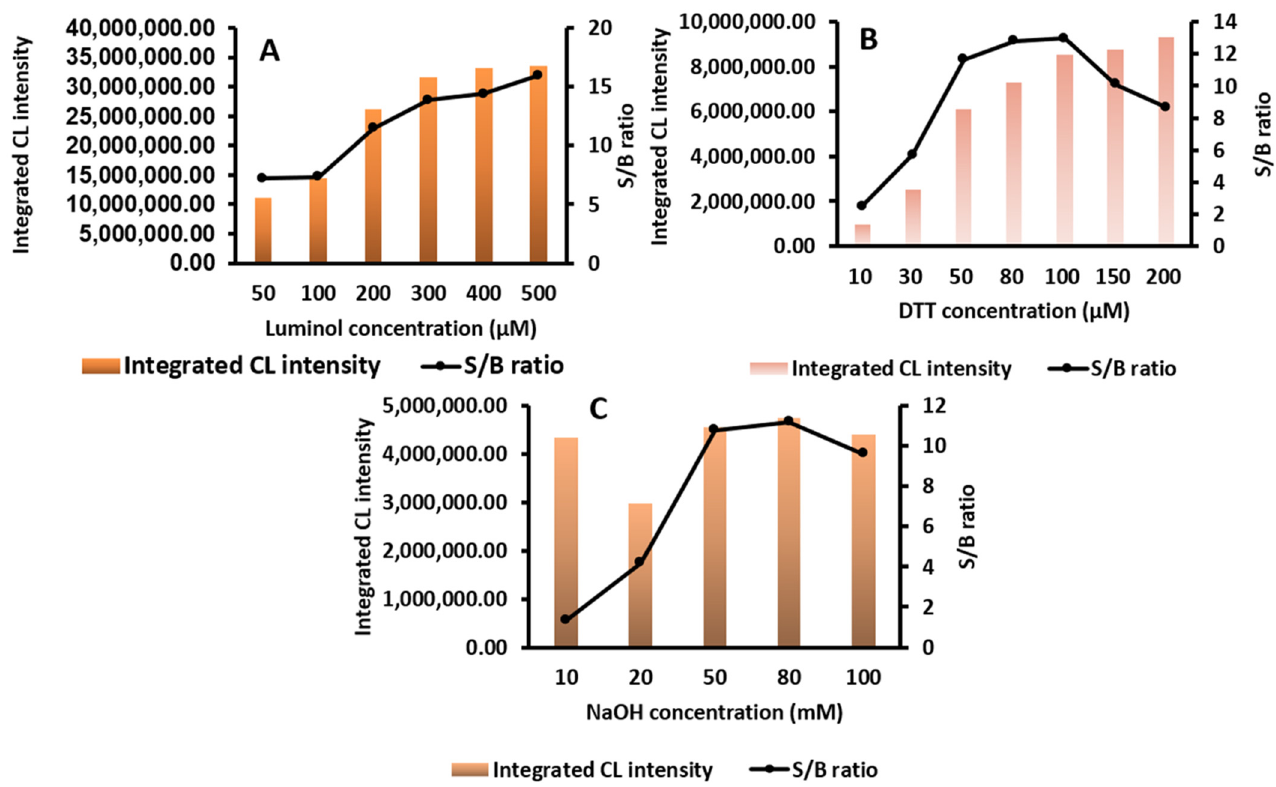
Figure 4. ( A ) Luminol concentration optimization in a luminometer displayed as integrated CL intensity and S/B ratio. ( B ) DTT concentration optimization in a luminometer displayed as integrated CL intensity and S/B ratio. ( C ) NaOH concentration optimization in a luminometer displayed as integrated CL intensity and S/B ratio.